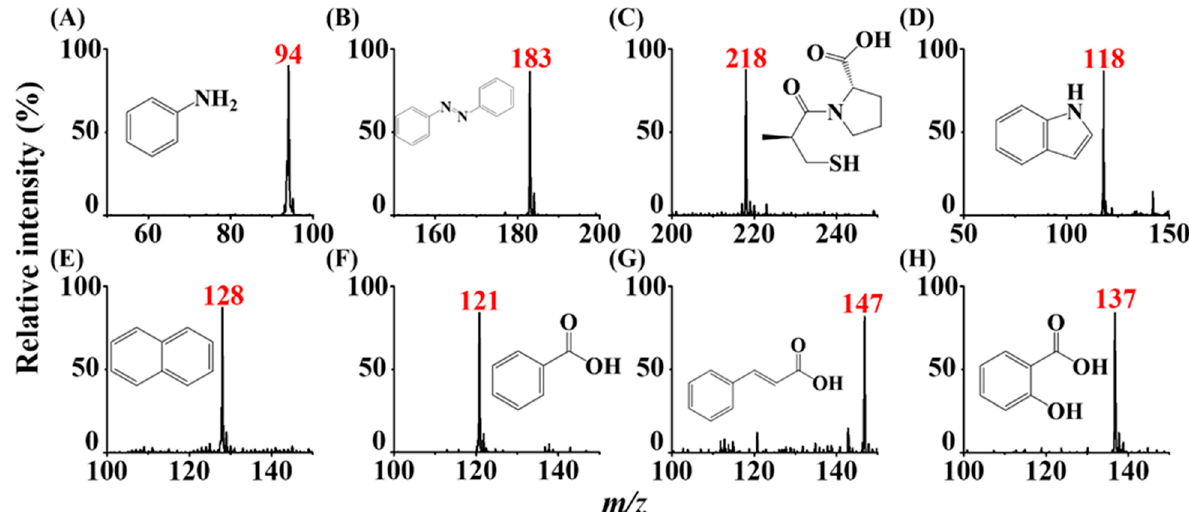
Figure 3. Analysis of analyte vapors derived from liquid samples. ASAI mass spectra of the samples including ( A ) aniline, ( B ) azobenzene, ( C ) captopril, ( D ) indole, ( E ) naphthalene, ( F ) benzoic acid, ( G ) cinnamic acid, and ( H ) salicylic acid prepared in methanol. The concentration of the samples were 10 − 4 M. The vial containing the sample solution (1 mL) was placed under the titanium slab (0.3 cm × 0.3 cm) at a distance of ~1 cm from the surface of the liquid sample. The voltages set on the inlet of the mass spectrometer were − 4500 V and +4500 V operated in the positive ion mode and the negative ion mode, respectively.